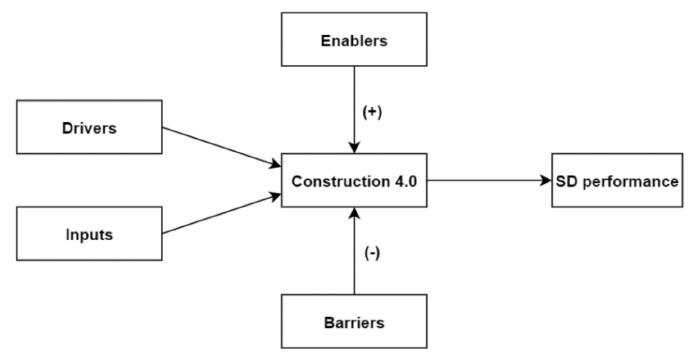
Figure 10. Framework to investigate critical success factors of using C4.0 for